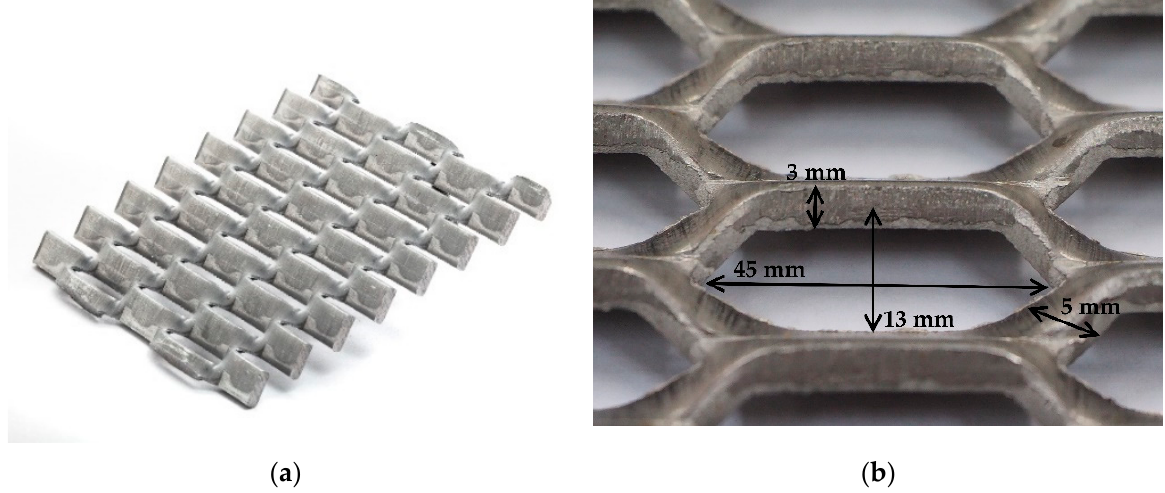
Figure 1. ( a ) Piece of expanded metal; ( b ) detail: open area of 24%, hole size of 45 mm × 13 mm, thickness of 3 mm, apparent thickness of 9 mm, strand of 5 mm.